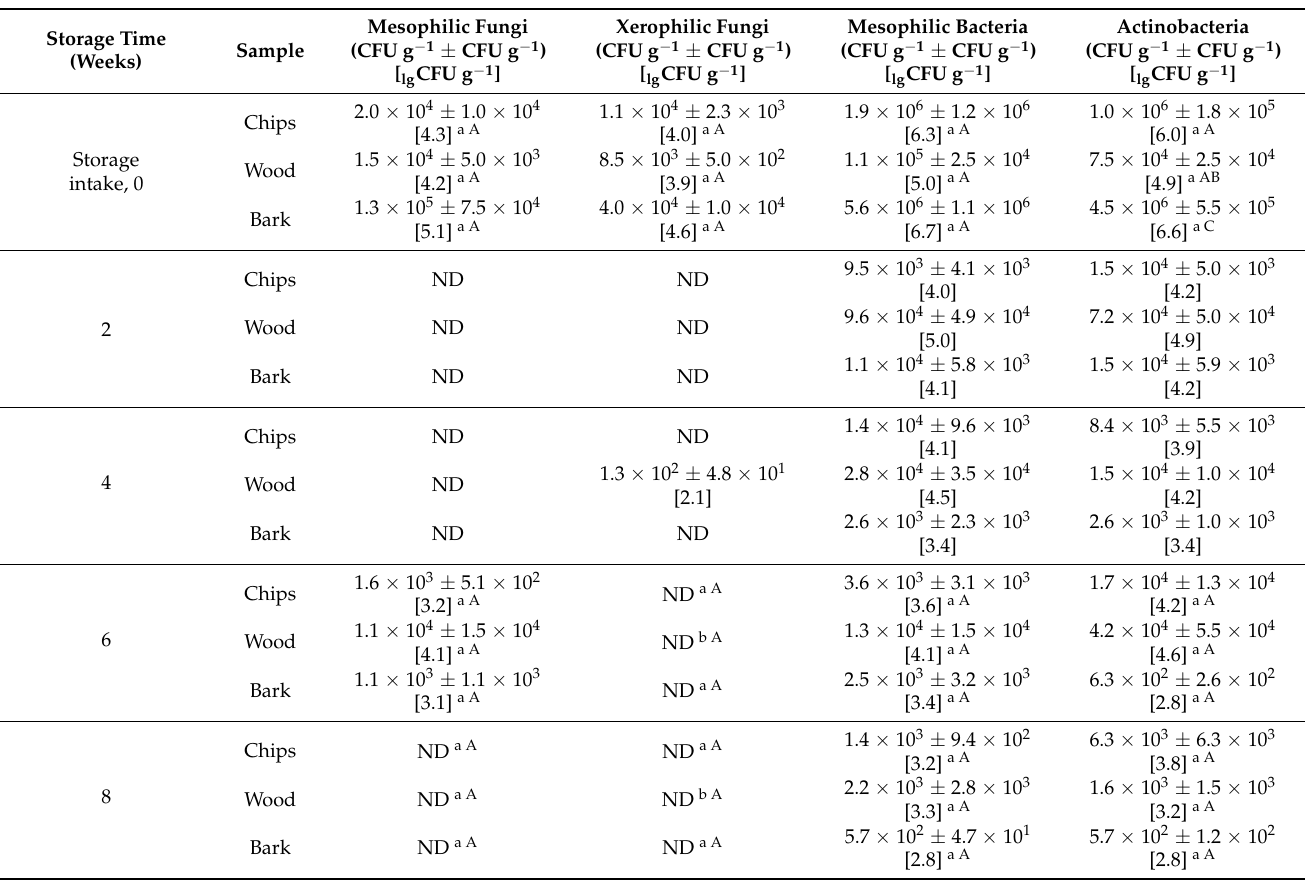
Table A5. Results of the microbiological analysis of the chips, wood and bark in trial T2; presented as mean ± standard deviation, both in colony forming units per gram of sample (CFU g − 1 ). In brackets, the mean is expressed as logarithmic to base 10 ( lg CFU g − 1 ). Different small letters indicate significant differences between storage intake and end of storage ( p < 0.05). Different capital letters indicate significant differences between wood fractions at storage intake respectively at week 6 or 8 ( p <